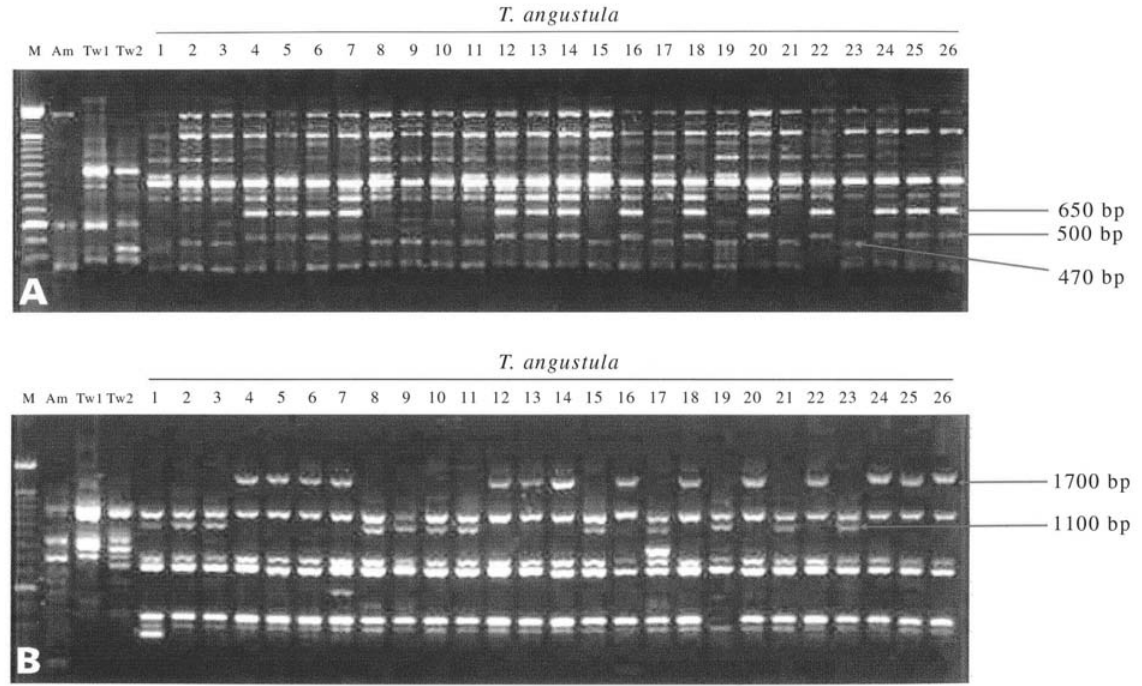
Figure3 -Agarosegel(1%)electrophoresisofampliconsobtainedwiththeMAU-B2primer (A) andtheOPL11primer (B) .M=DNAMolecularweight Marker (Gibco-BR), Am- Apis mellifera, Tw1 and 2- T. weyrauchi . Lanes 1 to 26 are T. angustula samples: 1- Panama, 2- Mirador, 3- Barra do Corda, 4- Porangatu, 5- Rio Verde, 6- Campinápolis, 7- Ladário, 8- Domingos Martins, 9- Maricá, 10- São Francisco, 11- Bocaiúva, 12 and 13- Uberlândia, 14- Grupiara, 15- Araxá, 16- Campina Verde, 17- Canaã, 18- Ribeirão Preto, 19- Pedreira, 20- Pilar do Sul, 21- Curitiba, 22- Prudentópolis, 23- Blumenau, 24- Posadas, 25- Aristóbulo del Valle, 26 - Cerro Azul. The arrows indicate the markers of groups 1 and